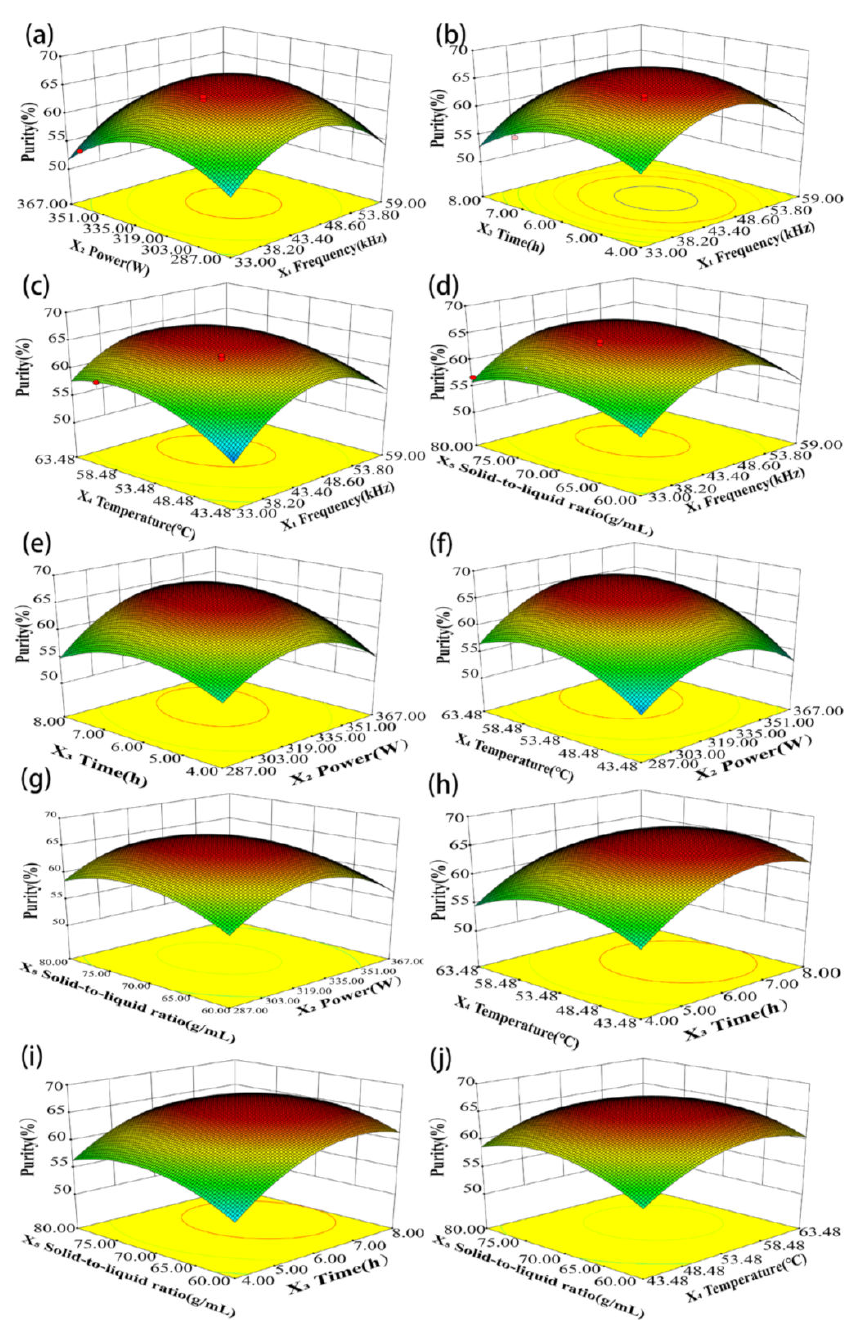
Figure 4. 3D response surface curves of interactive effects between different ultrasonic factors. frequency; X 2 , power; X 3 , time; X 4 , temperature; X 5 , material-to-liquid